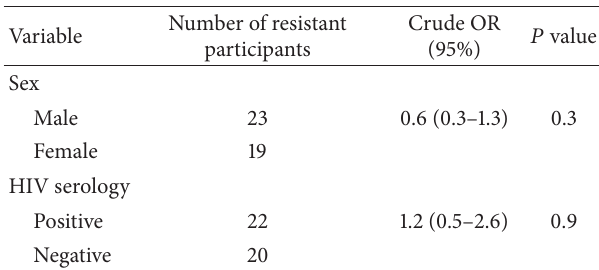
Table 2: Demographic, clinical characteristics of TB participants according to general resistance to anti-TB